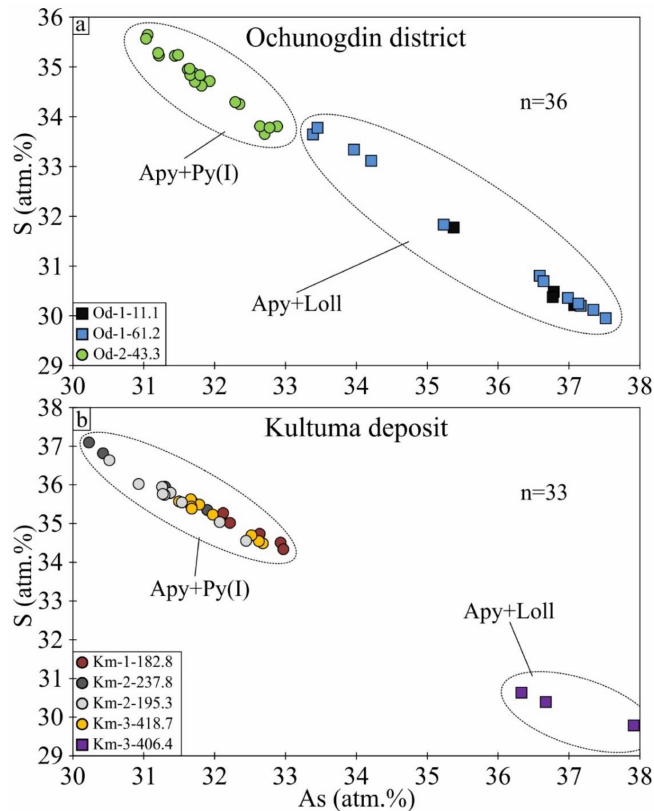
Figure 11. Variations in composition of arsenopyrite (S and As atomic %) from samples studied. Note the wide variation of As content in arsenopyrite both at the Ochunogda region ( a ) and Kultuma deposit ( b ) as a function of different mineral